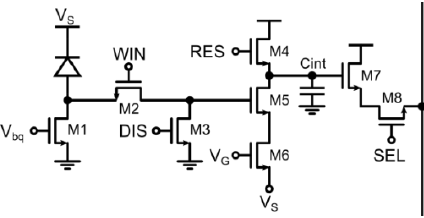
Figure 7. Analog counting pixel with coarse time gating for windows width larger than the SPAD dead time ( i.e. , >10 ns) [35].